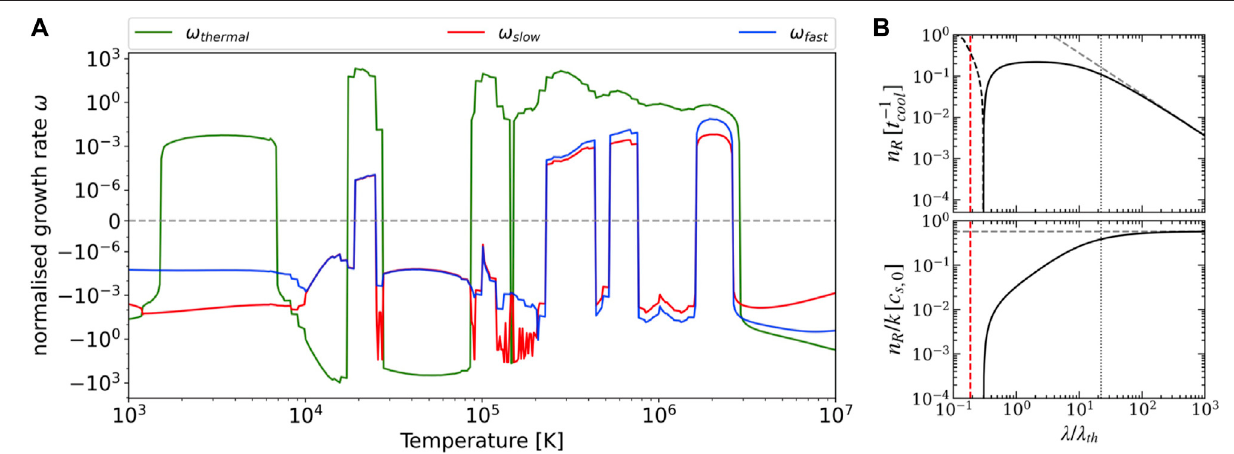
FIGURE 4 | (A) Growth rate (imaginary component of frequency) of the solutions of the dispersion relation for an in fi nite, homogeneous magnetised plasma in equilibrium for an angle of 45 ° between the wave vector and magnetic fi eld, including optically thin radiative losses, parallel and perpendicular thermal conduction (and neglectingtheeffectsofgravityandresistivity)asafunctionoftemperature.Theequilibriumvaluesareadensity ρ =9.64×10 – 14 g cm − 3 ,amagnetic fi eldstrengthof B = 10 G and a length scale of L = 10 8 cm . Green, red and blue curves denote the thermal, slow and fast mode growth rates, respectively. This plot is adapted from Figure 1 in Claes and Keppens. (2019) (reproduced with permission © ESO) but modi fi ed by N. Claes to include the more modern cooling curve by Schure et al. (2009), extendedtolowtemperaturesusingDalgarnoandMcCray(1972)(seealsoClaesandKeppens,2021,formoredetails). (B) Growthrateoftheentropymode n R (top)and n R / k (cf. Eq. 6 ) as a function of perturbation wavelength λ = 2 π / k . The dashed portion of n R denotes negative values corresponding to stabilisation due to thermal conduction(theField ’ slengthisshowninred).Thegreydashedlinedenotestheasymptoticgrowthoftheentropymodewhen k → 0(cf. Eq.12 ).Thedottedverticallines denotes λ c ≈ 22.3 λ th (from Figure 1 in Waters and Proga, 2019, © AAS. Reproduced with